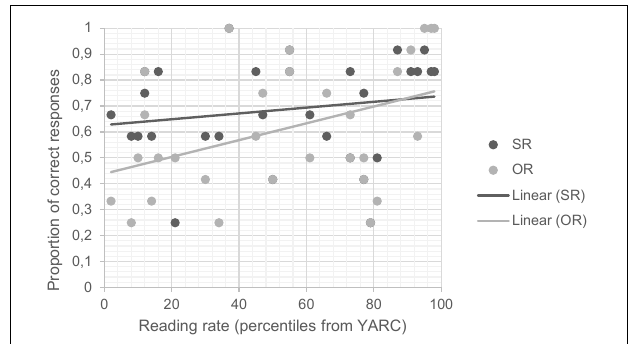
FIGURE 4 | Scatterplot reading – type in the match subset. SR, subject relative; OR, object relatives; YARC, York assessment of reading and